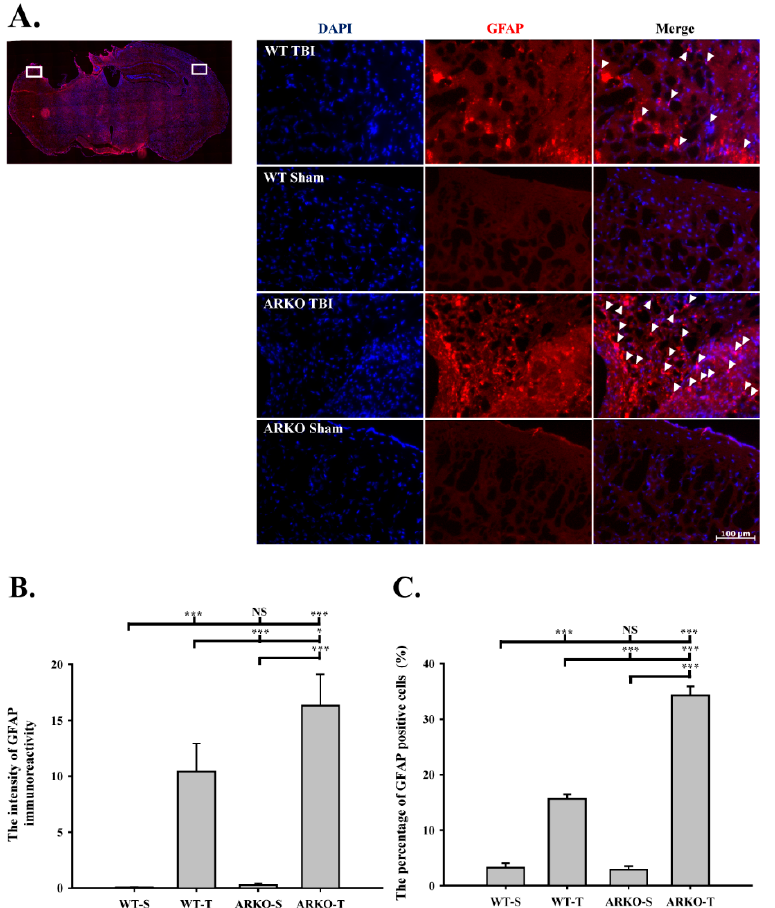
Figure 3. Androgen receptor knockout increases the TBI-induced GFAP expression around the cortical injury site. ( A ) Illustrations of the regions of interest (white areas) of the mice brain after TBI are shown in left panel. WT and ARKO mice were performed with TBI or sham, and then stained with immunofluorescence of GFAP. The GFAP positive cells were indicated by white arrowhead. ARKO mice showed the increasing cells of GFAP expression. Blue color, DAPI (4 ′ ,6-diamidino-2-phenylindole); red color, GFAP. (Images: x200 magnification of the ipsilateral and the contralateral hemispheres; scale bar = 100 μ m) ( B ) The intensity of GFAP immunoreactive level with normalized intensity fluorescence unit in the four experimental groups is presented. ( C ) The percentage of GFAP positive cells counterstained with DAPI in the four experimental groups is presented. The expression of GFAP at the cortical injury site was calculated from six different bregma levels. WT-S, wild-type sham; WT-T, wild-type with TBI; ARKO-S, ARKO sham; ARKO-T, ARKO with TBI. All data are presented as the mean ± standard error. NS, no significant difference; * p < 0.05, and *** p < 0.001; n = 7 in each group.